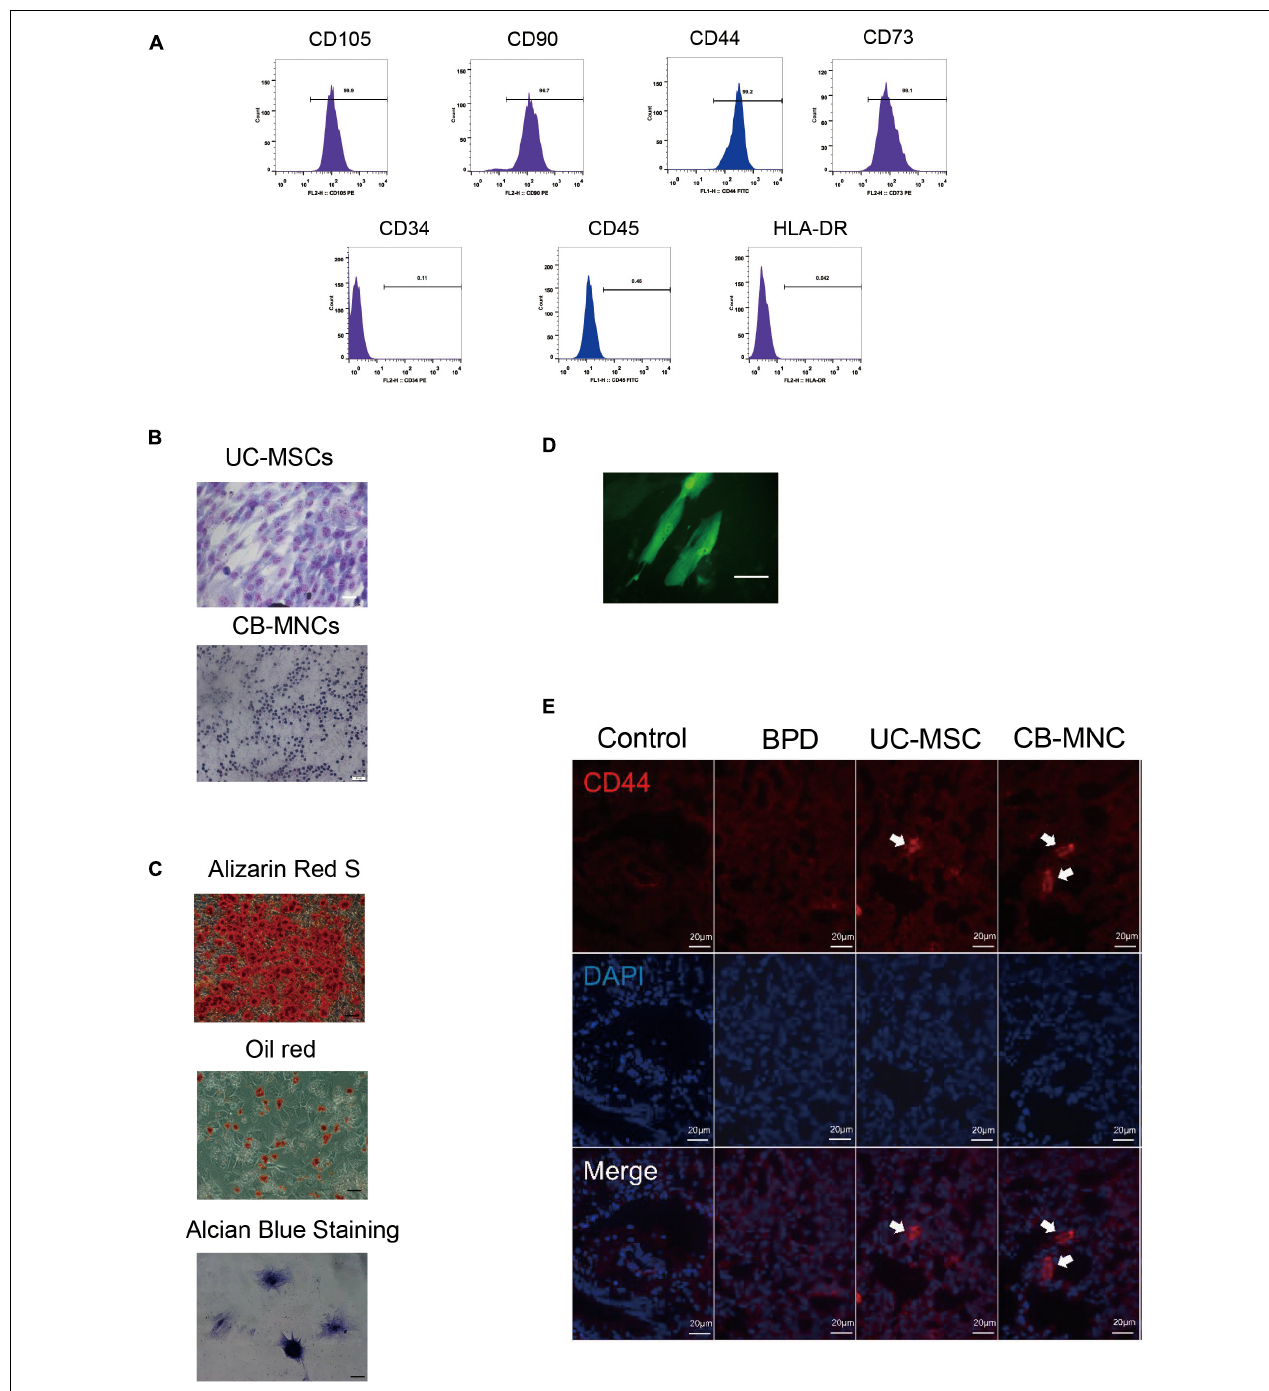
FIGURE 2 | Intravenous infusion of cord blood derived-mononuclear cell (CB-MNC) and umbilical cord derive-messenchymal stem cell (UC-MSC) through great saphenous vein injection. (A) Surface marker expression of umbilical cord-derived mesenchymal stem cells (UC-MSCs). Flow cytometry analysis indicated that UC-MSCs were positive for CD105, CD90, CD44, and CD73 but negative for CD34, CD45, and HLA-DR. (B) Wright–Giemsa staining illustrating the purity of UC-MSCs (upper panel, scale bar: 50 µ m) and cord blood-derived mononuclear cells (CB-MNCs) (lower panel, scale bar: 50 µ m). (C) The lineage differentiation capacity of UC-MSCs was revealed by induction of distinct reagents. Alizarin red S for osteogenic capacity, oil red O for adipogenic capacity, and Alcian blue for chondrogenic differentiation, scale bar: 50 µ m. (D) Fluorescent image indicating the successful infection of green fluorescent protein (GFP)-lentivirus in MSC, scale bar: 20 µ m. (E) Immunofluorescence analysis of lung tissues infused with indicated cells. CD44 antibodies were used to detect human-derived CD44 (red), blue staining shows cell nuclei [4 (cid:48) ,6-diamidino-2-phenylindole (DAPI)]. Images are representative of three independent experiments, scale bar: 20 µ m. Data are representative of three independent biological